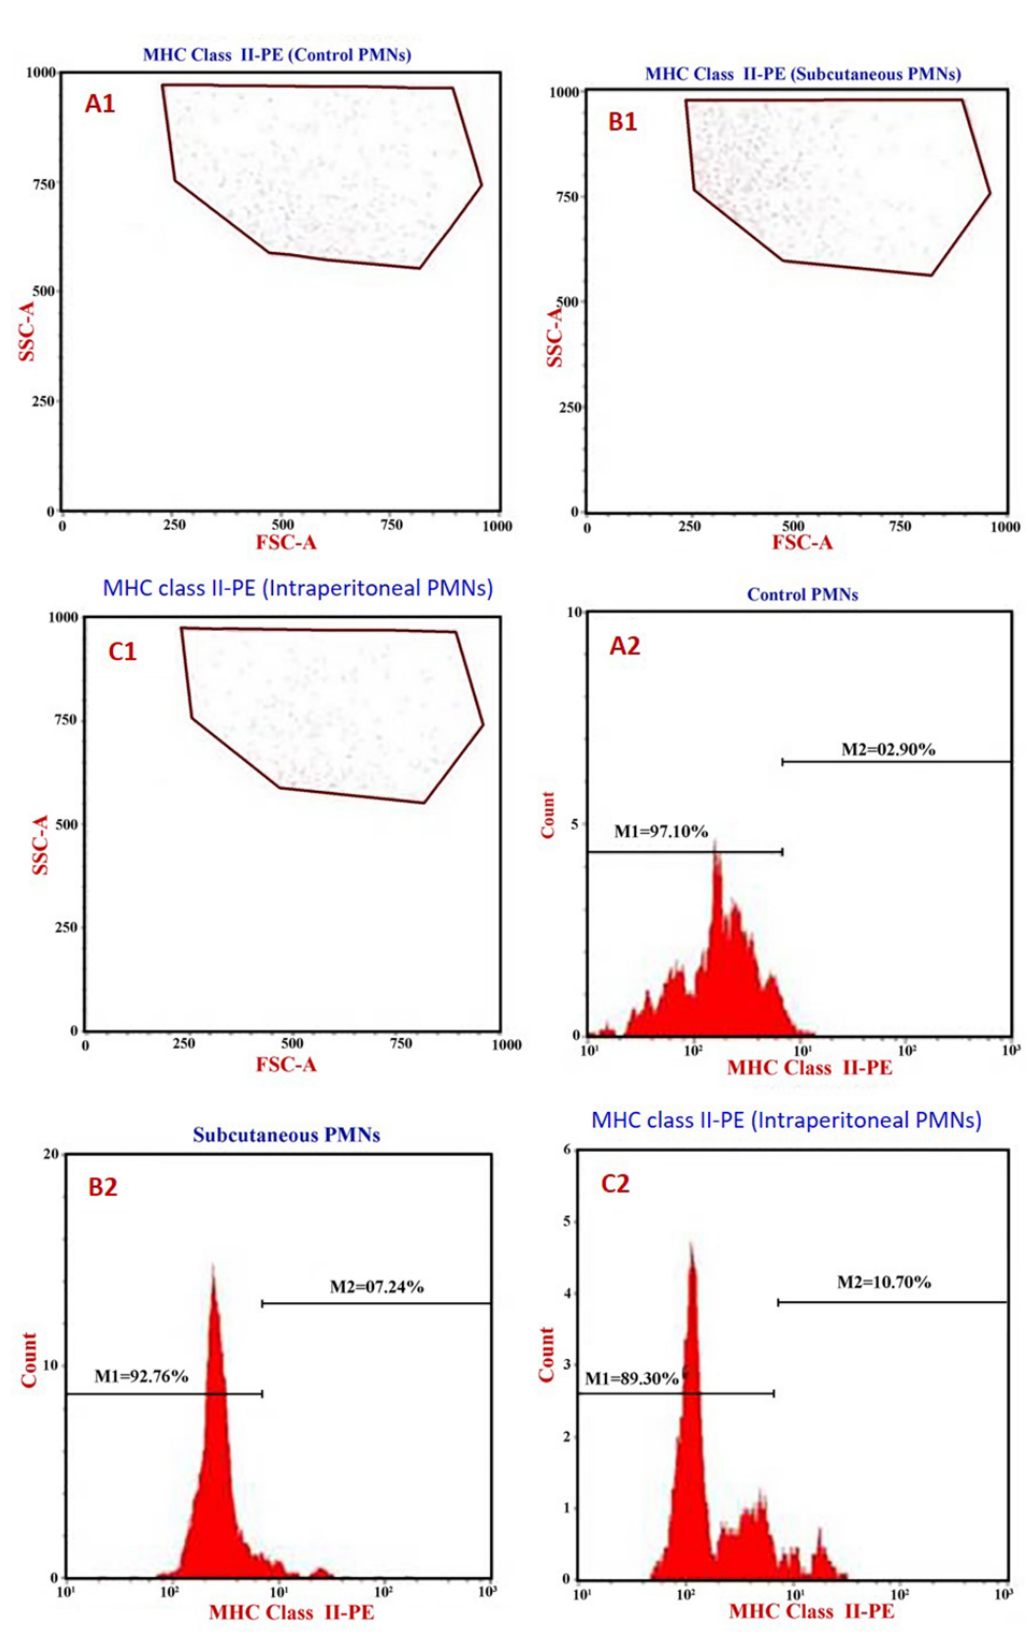
Figure 4. Representative cytoflourometry graphs of the MHC class II induction in the whole blood PMNs. (A1, A2) Unstimulated PMNs (control). (B1, B2) Subcutaneous SAV-stimulated PMNs. (C1, C2) Intraperitoneal SAV-stimulated